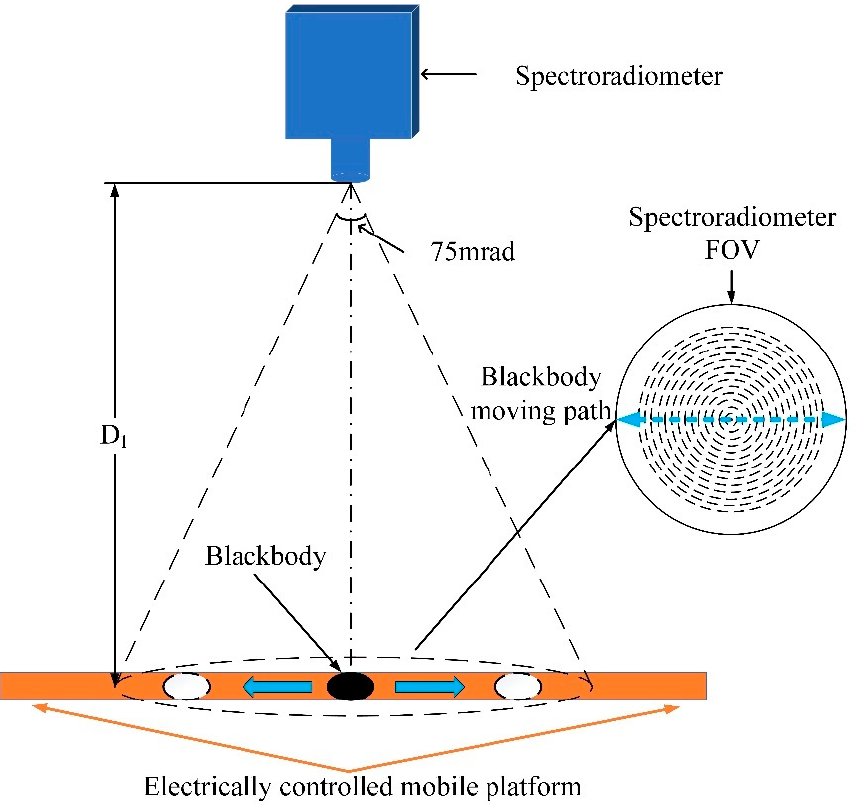
Figure 2. Schematic diagram of the experimental setup for measuring the spatial nonuniformity of the spectroradiometer FOV.